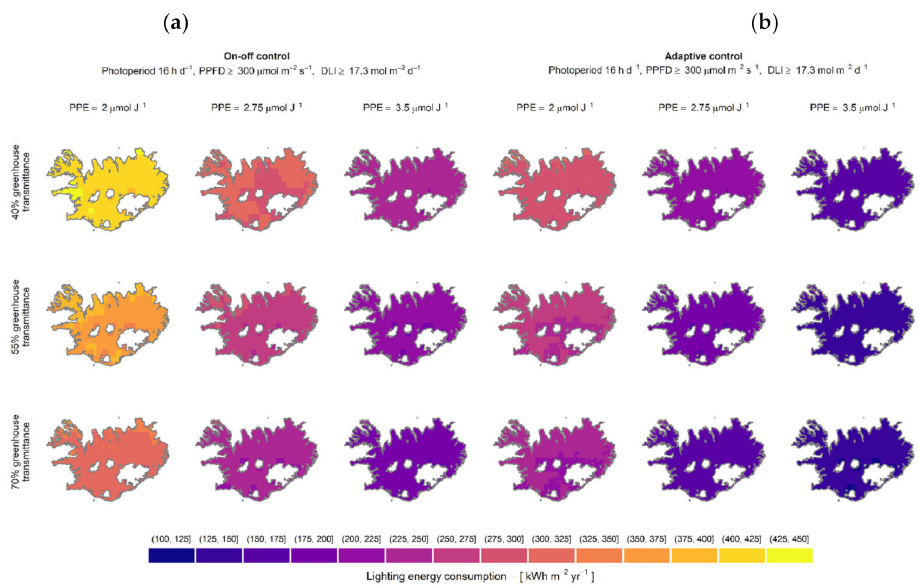
Figure A5. Yearly lighting energy consumption (E el, lamps , kWh · m − 2 · yr − 1 ) maps of Iceland for the chosen greenhouse cultivation period of 181 days: from 1 February to 20 May and from 20 August to 31 October. The electric energy demand of the lamps was calculated for a photoperiod of 16 h · d − 1 with a PPFD threshold of 300 µ mol · m − 2 · s − 1 , considering three different photosynthetic photon efficacies (PPE: 2, 2.75 or 3.5 µ mol · J − 1 ) and three possible greenhouse hemispherical transmittances ( τ h, PAR : 40%, 55% or 70%). The two panels compare different lighting control protocols: ( a ) On-off control; ( b ) Adaptive control. Values presented as a 0.05 ◦ × 0.05 ◦ grid both in latitude and longitude, extending from 63 ◦ N to 67.5 ◦ N in latitude and 13 ◦ W to 25 ◦ W in